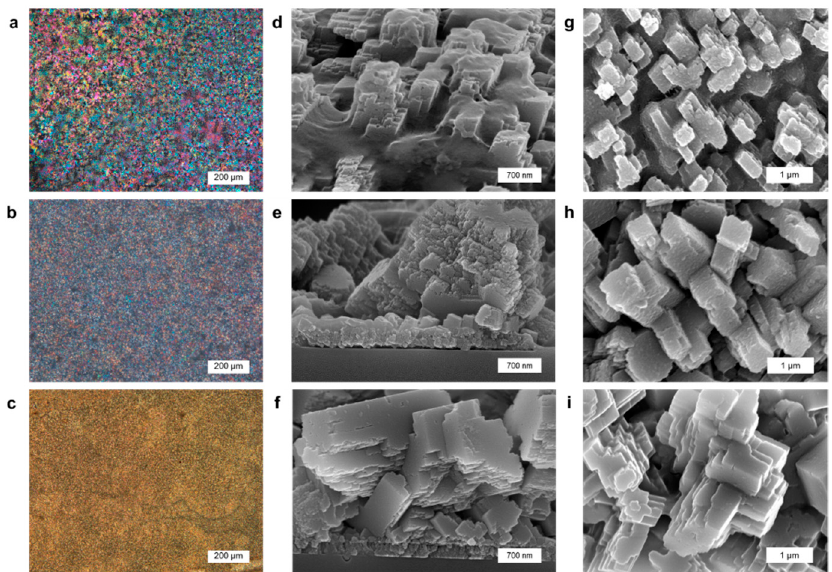
Figure 3. Structural characterization of rhombohedral CaCO 3 -SF hybrid films in 4 wt% ( a , d , g ) and 1 wt% SF hydrogels ( b , e , h ) and in the absence of SF hydrogels ( c , f , i ). Corresponding POM images ( a – c ), side- ( d – f ) and top-view ( g – i ) SEM images of rhombohedral films are listed in the left, middle, and right